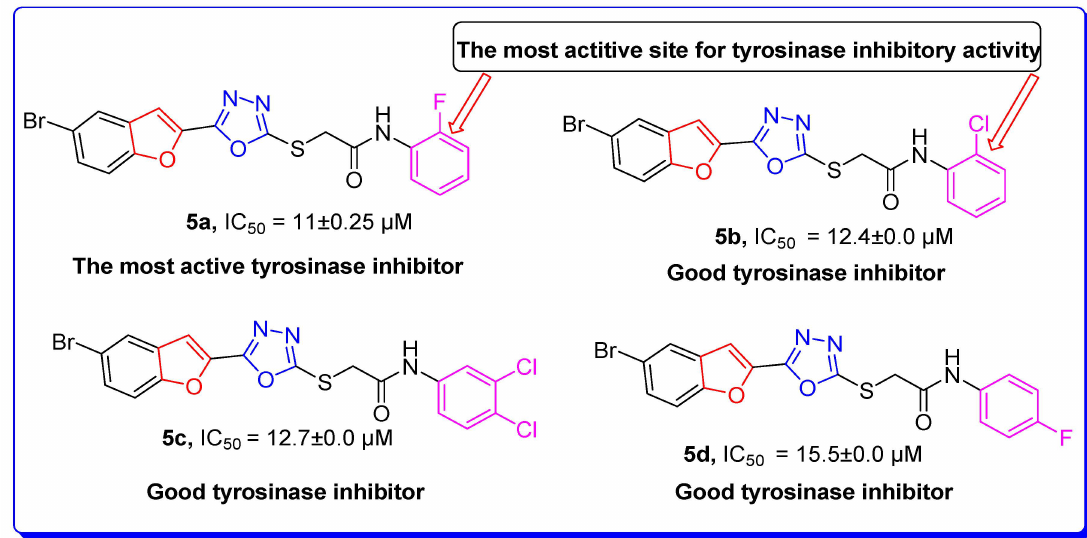
Figure 4. The most biologically active oxadiazole-based furan derivatives 5a–5d as tyrosinase inhibitors.